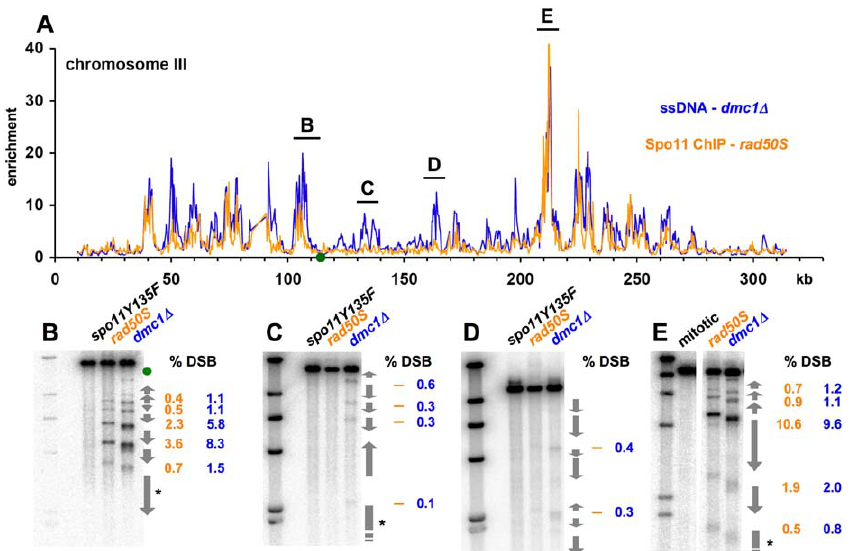
Figure 5. Confirmation of DSB Patterns (A) Spo11 ChIP ratios from rad50S (orange) and BND cellulose enriched ssDNA ratios from dmc1 D (blue) on chromosome III . Green dot indicates the centromere. (B–E) Southern blot detection of DSBs in the indicated regions. Blots contain DNA from meiotic (5 h) samples of spo11-Y135F dmc1 D (MJL3096), dmc1 D (MJL3095), and rad50S (MJL1083) cells, and DNA from mitotic wild-type (MJL1578) cells. DSB frequencies (% total lane signal) are indicated to the right of each blot (- denotes no signal detected above background). Blots were hybridized with radioactive probes (*) internal to YCL011c , YCR007c , YCR052w open reading frames (for (B), (C), and (E), respectively; details supplied upon request), and YCR019w in (D). Restriction enzymes used: (B and C): Xho I; (D): Pvu II; and (E): Bgl II. DNA length standards (first lane in each blot) contain a Hin dIII digest of phage k DNA.